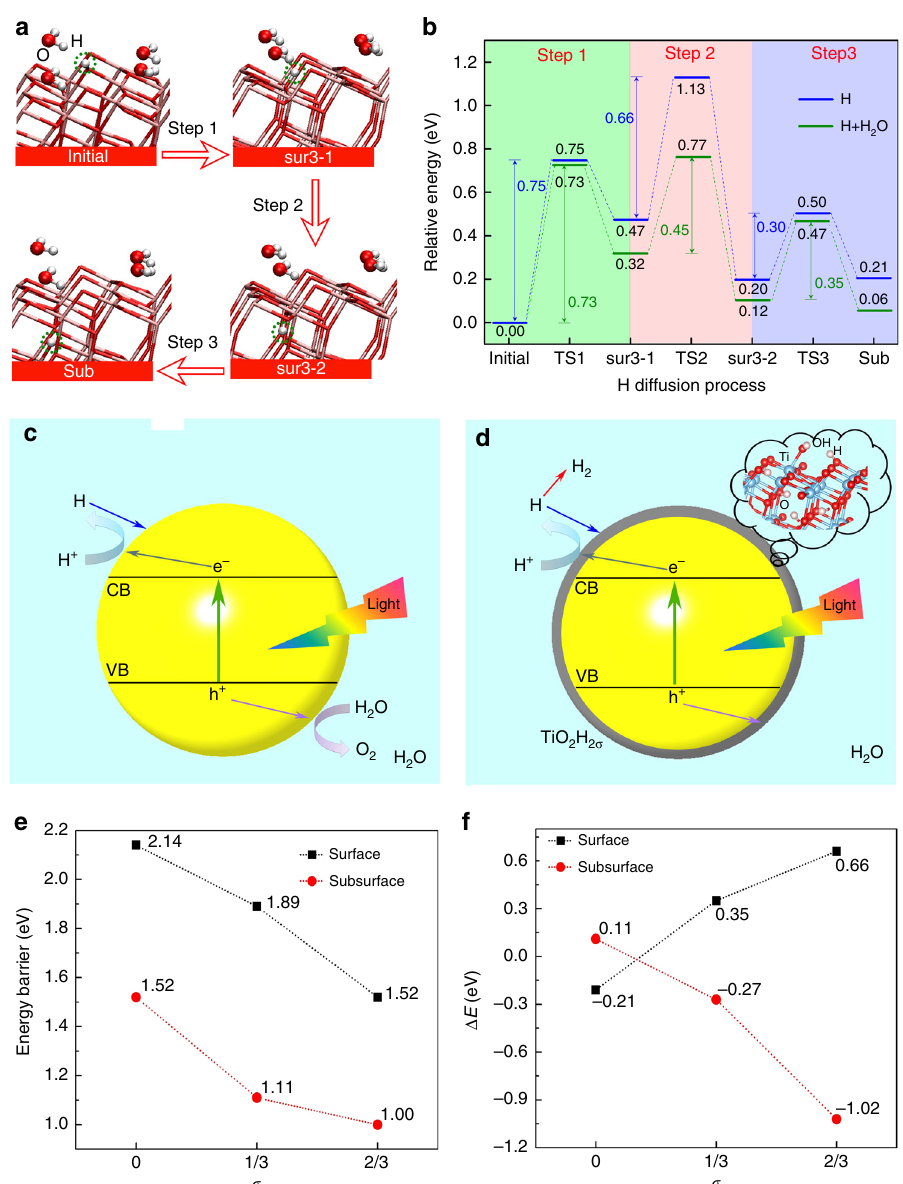
Fig. 2 Formation mechanism and reactivity of the hydrogenated TiO 2 shell. a Atomic structures of four key intermediates — initial state, sur3-1 state, sur3-2 state, and sub state — in the surface subsurface diffusion of a H atom. In the sur3-1 (sur3-2) state, atomic hydrogen is adsorbed on a surface three-fold O with the hydrogen pointing toward the vacuum (toward the bulk). In the sub (or fi nal) state the hydrogen is adsorbed at a subsurface O atom. The O atom is red, H is gray blue, and the pink-red sticks represent the TiO 2 system. Red arrows indicate the three steps (Steps 1 – 3) for the diffusion of H (marked by the green dot circle) into TiO 2 . b Potential energy pro fi le for the surface subsurface diffusion of atomic hydrogen. Energies are relative to the initial state, and ‘ TS ’ indicates transition states. Blue and green bars represent energies in the absence and presence of adsorbed water, respectively. c Schematic representation of the photocatalytic process: under UV light, the photoexcited electron – hole pairs can split water to form hydrogen and oxygen. d Modi fi ed photocatalytic process described in this work: the hydrogen atoms diffuse fi rst into TiO 2 (blue arrow) to form the hydrogenated TiO 2 shell on the NP 14,15 before they are desorbed into water to form the hydrogen bubble. e , f Energy barriers and the desorption energies for the process of H 2 formation on the TiO 2 (101) surface or subsurface as a function of the H/O ratio σ in the inner TiO 2 ,